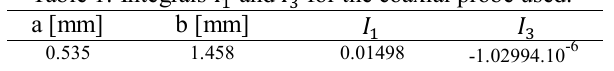
Table 1: Integrals 𝐼 1 and 𝐼 3 for the coaxial probe